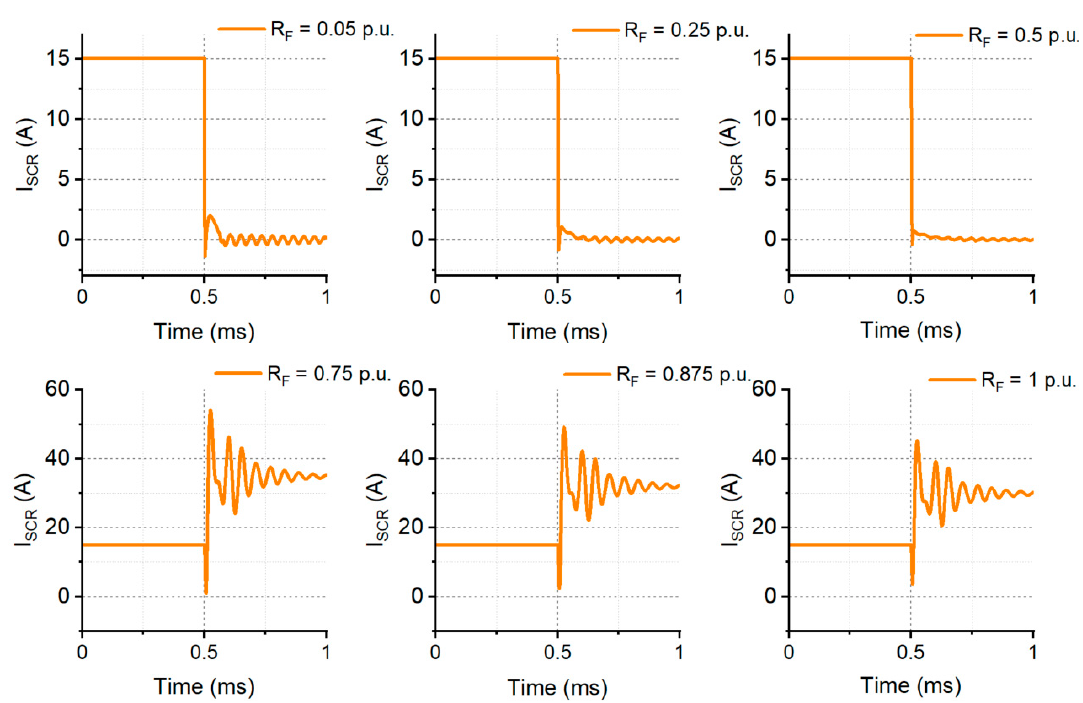
Figure 5. A simulation study of the ICC-BZCB’s effectiveness with various R f values, with a 10 km line.